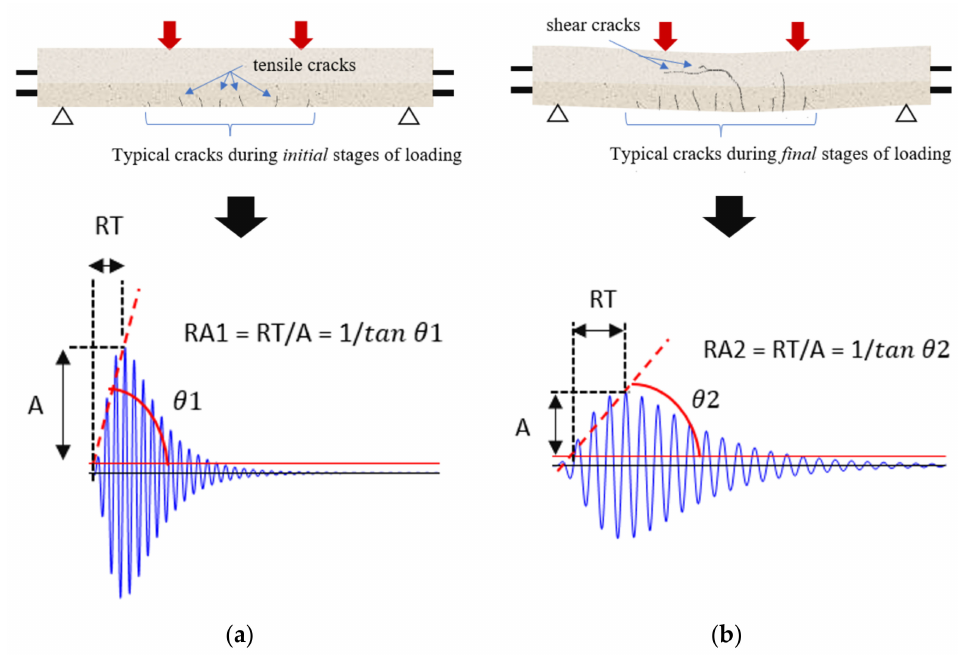
Figure 8. Schematic presentation of cracks and the corresponding dominating AE signals: ( a ) cracks during initial stages of loading and AE signal, and ( b ) cracks during final stages of loading and AE